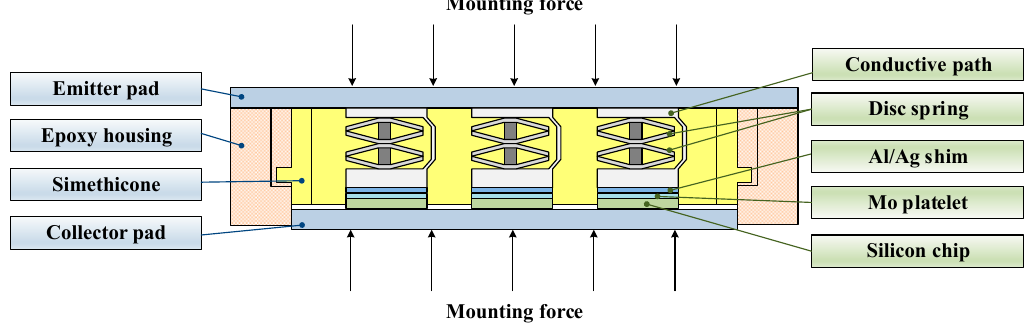
Figure 4. Internal schematic diagram of the press-pack submodule from a cross-sectional view.